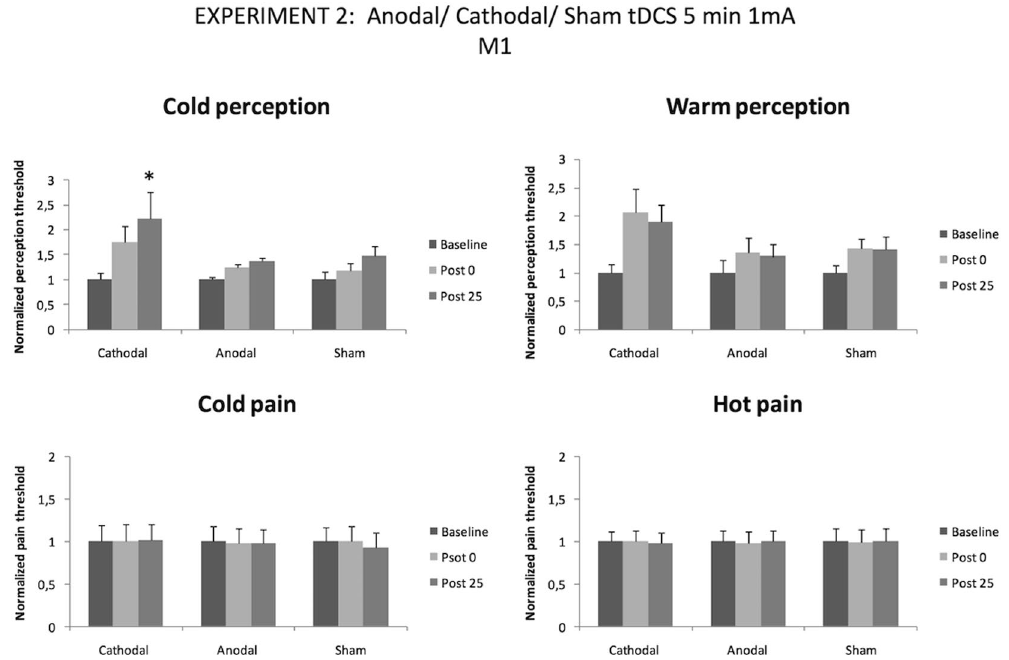
Figure 4. Temperature perception thresholds for warm and cold perception (anodal, cathodal and sham stimulation, tDCS 5 min 1 and 2 mA over motor cortex). Error bars are standard deviations. * p <